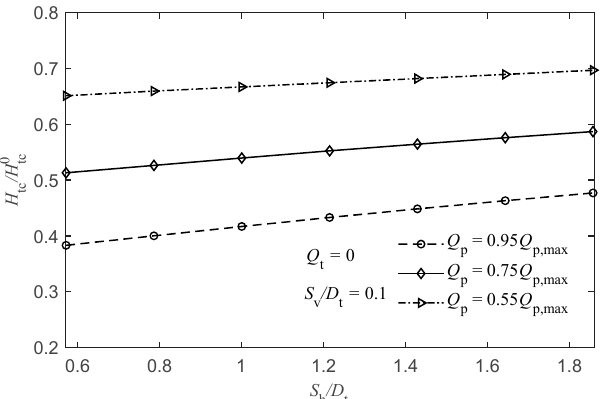
Figure 11. Relative pressure head on the tunnel crown versus horizontal distance between the parallel adit and tunnel.